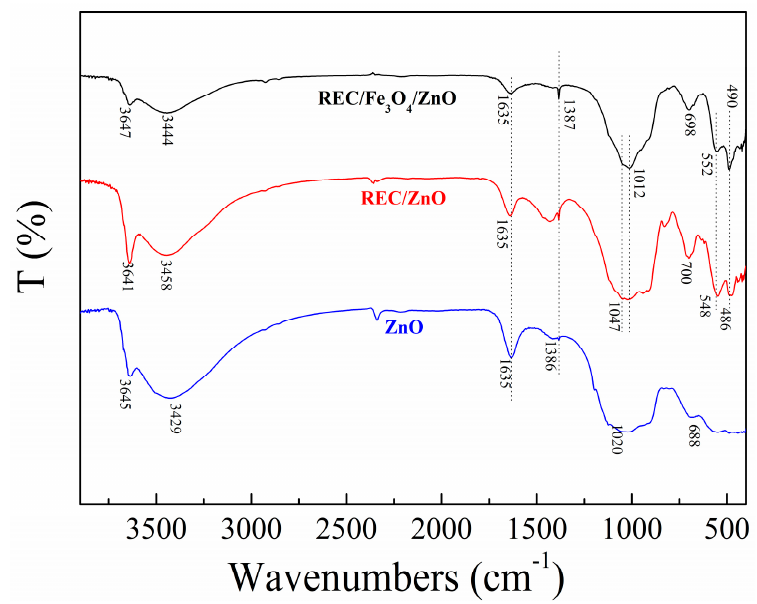
Figure 3. Fourier transform ‐ infrared (FT ‐ IR) spectra of ZnO, REC/ZnO (1:0.5), and ZnO/REC/Fe 3 O 4 (1:0.3:0.5).